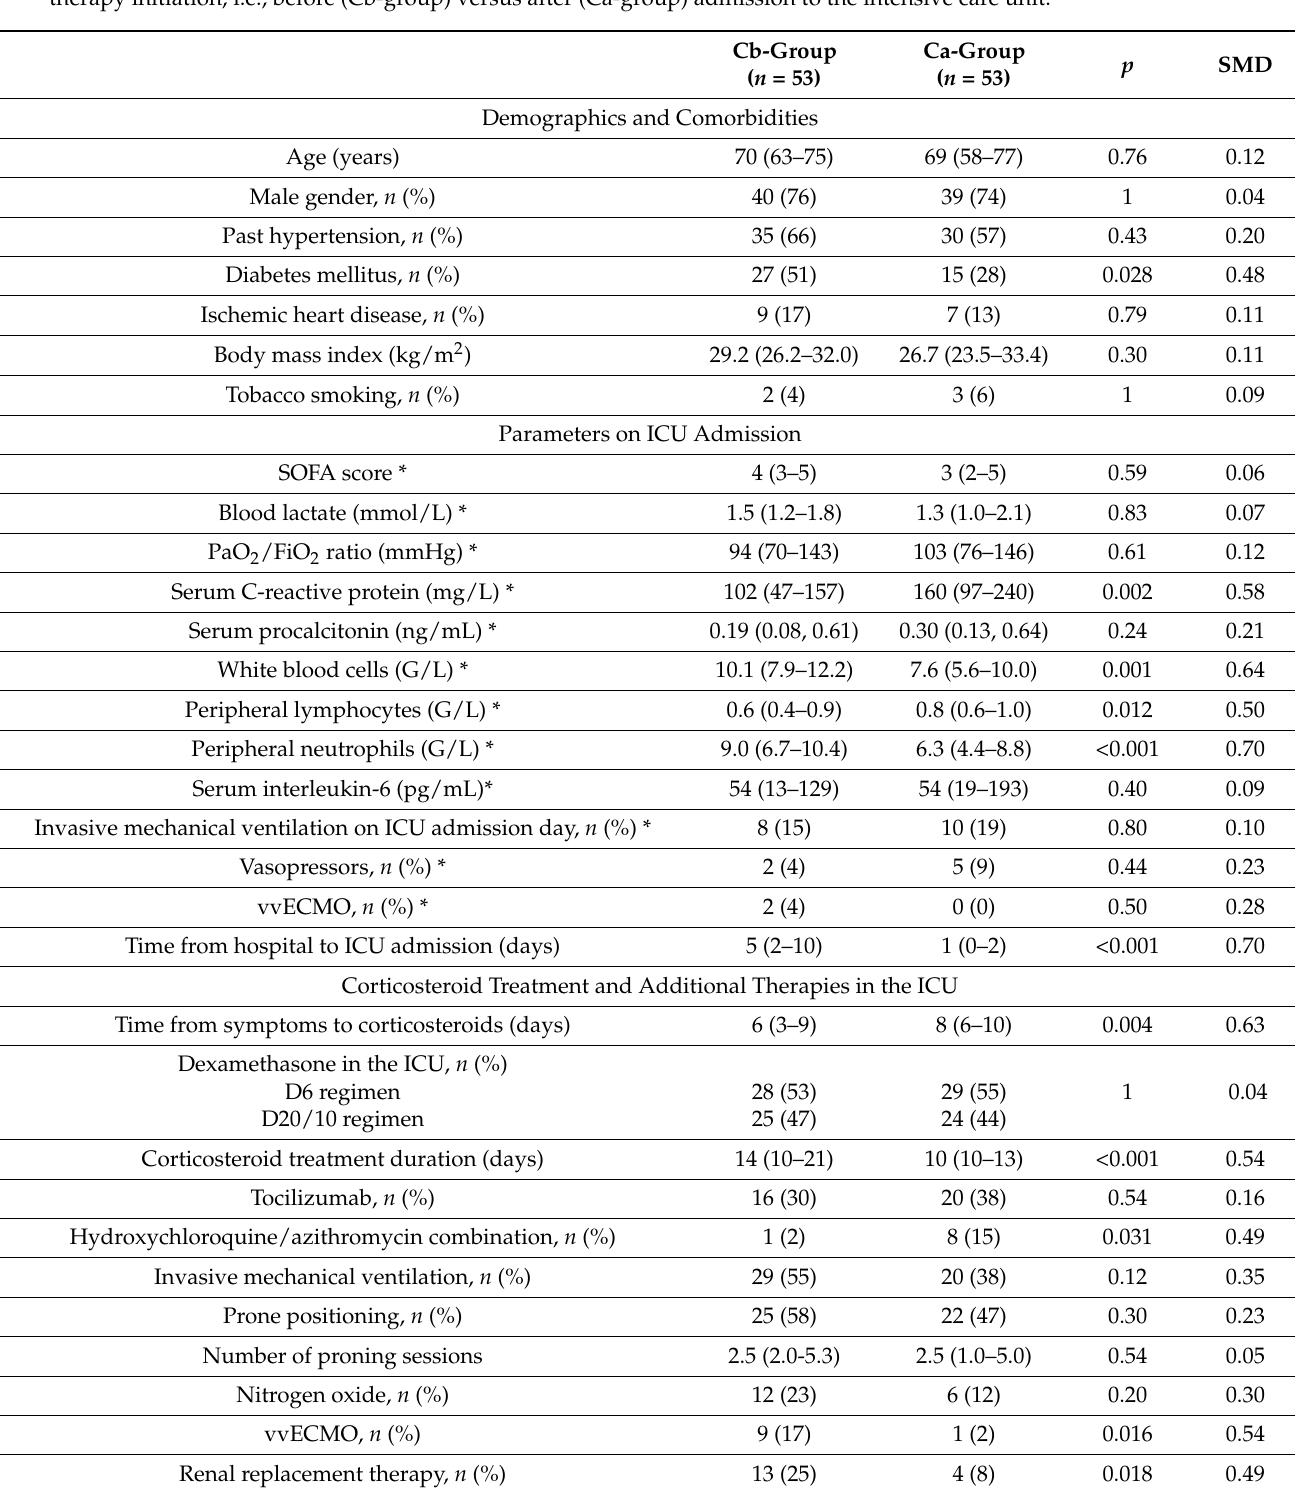
Table 3. Patient characteristics and outcomes after propensity score matching according to the setting of corticosteroid therapy initiation, i.e., before (Cb-group) versus after (Ca-group) admission to the intensive care